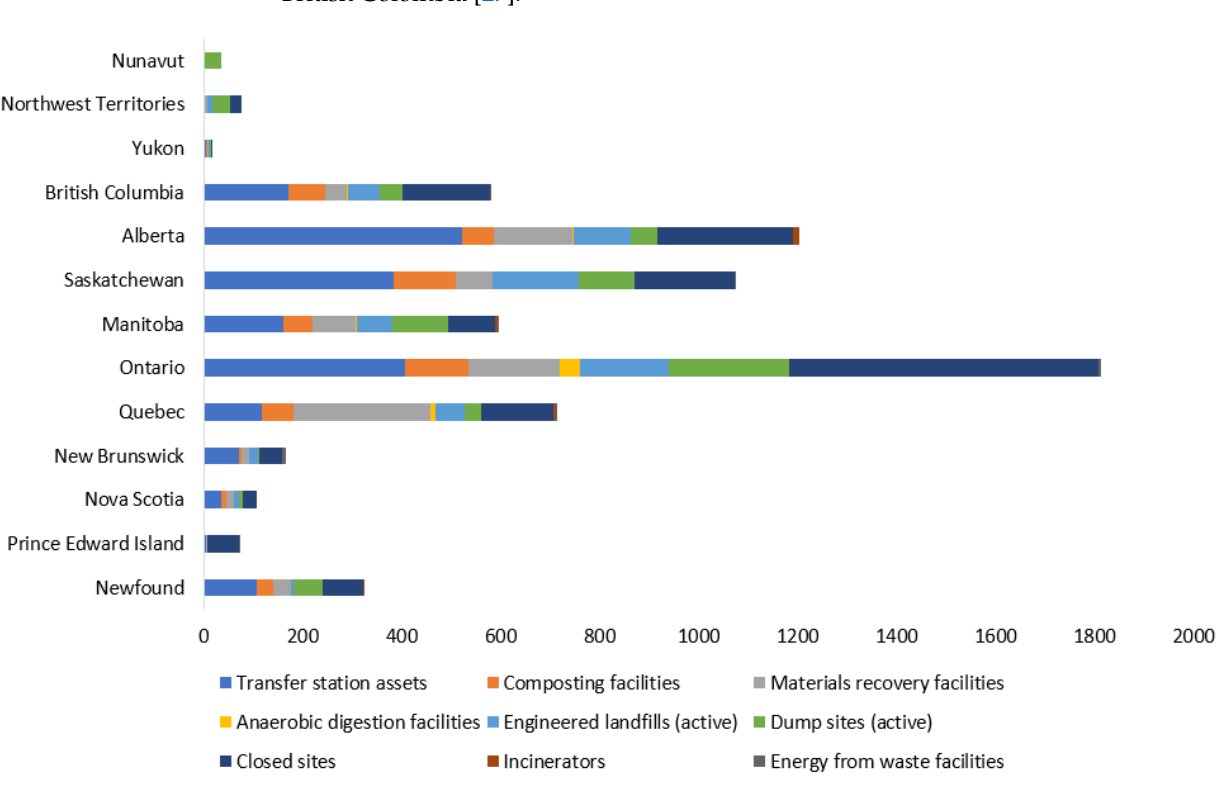
Figure 3. Public-owned MSW management infrastructures in Canada. The authors originally produced the figure from Canada’s national statistical agency [28].